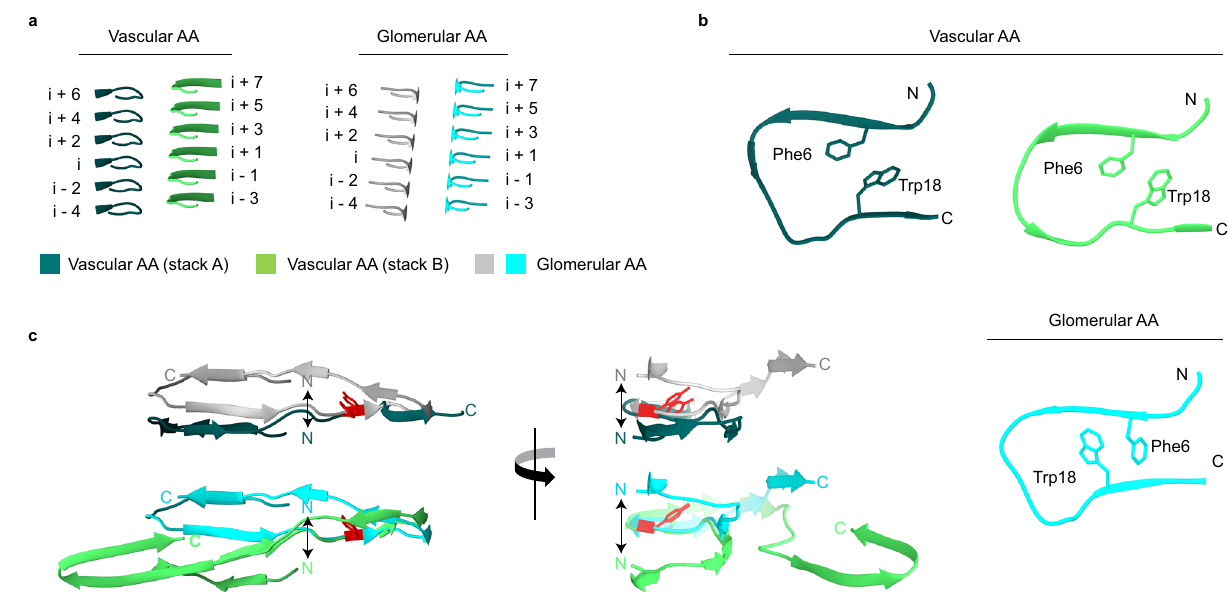
Fig.4|Detailstructuralfeaturesofthevascularandglomerular fi bril.a Ribbon diagrams of residues Ala27-Asp33 which are close to the fi bril axis, in the vascular andglomerular fi brils,showingthestaggeredarrangementofthetwo fi brilprotein stacks. The fi bril proteins are labeled with i − 4 to i +7. b Ribbon diagrams of residues Ser2-Ala20 from the N-terminal arch, indicating the fl ipped positions of